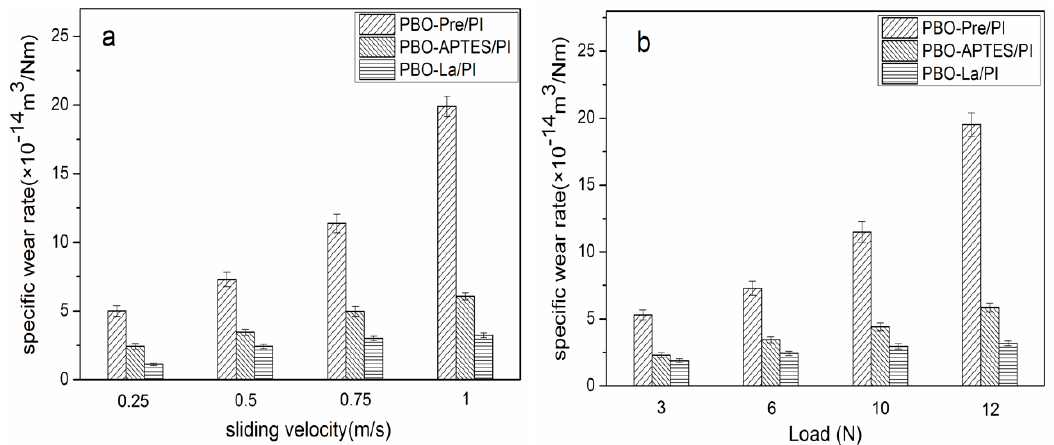
Figure 15. The specific wear rate of PI composites in a 260 °C environment as a function of ( a ) sliding velocity (load: 6 N) and ( b ) load (velocity: 0.5 m / s).